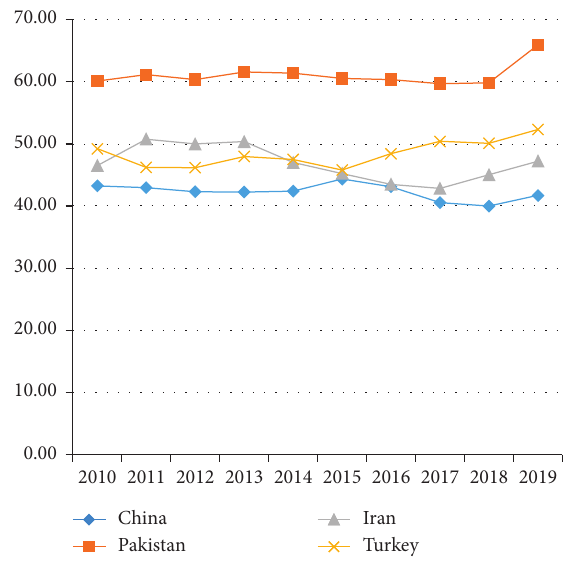
Figure 11: The operational risk trends to CPITC